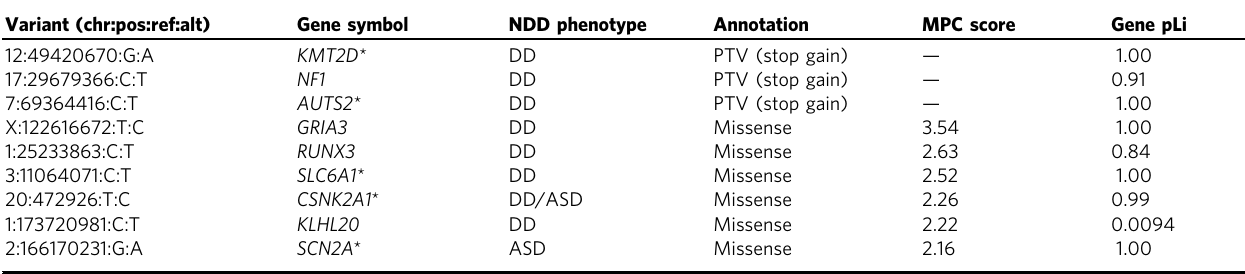
Table 2 NDD primary variants that are observed as de novo mutations in